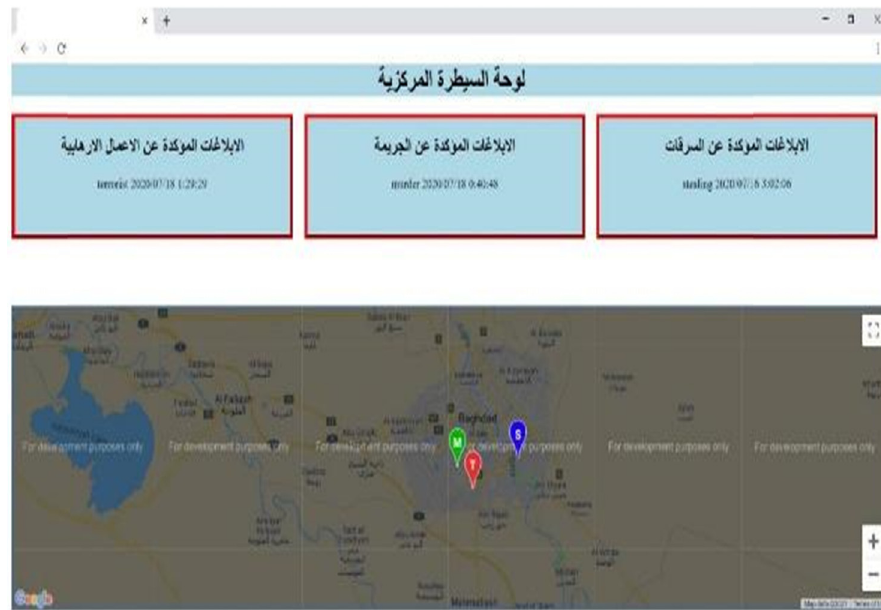
Figure 9: Controlling and validating crime reporting system.